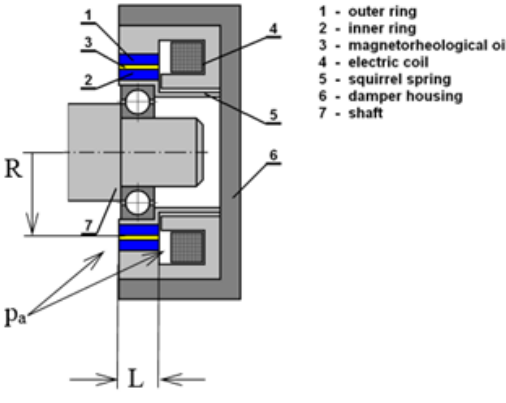
Fig. 1. Apllication of squeeze film damper